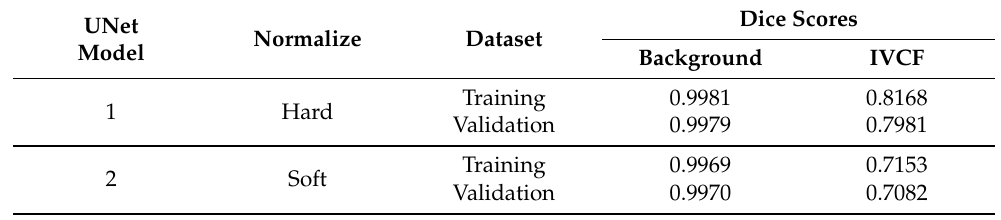
Table 1. Dice score for different model variants.